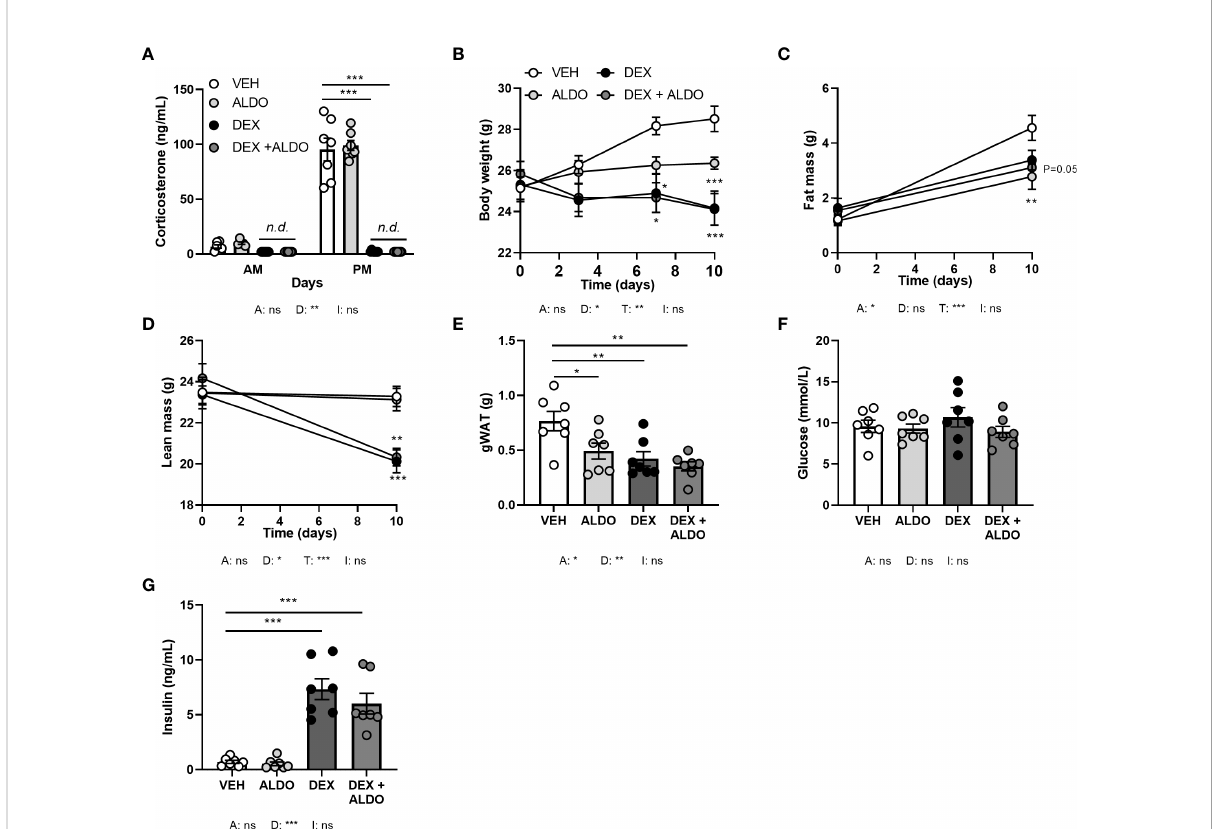
FIGURE 7 Aldosterone add-on treatment did not in fl uence the metabolic effects of dexamethasone. Mice received a high-fat diet mixed with dexamethasone (DEX) or vehicle (VEH) and were subcutaneously implanted with aldosterone (ALDO) or vehicle pellets for 10 days. (A) ALDO did not affect corticosterone levels at AM (ZT1) and PM (ZT11) of the light phase, while CORT levels were not detected (n.d.) after DEX and DEX + ALDO treatment. (B – D) DEX + ALDO did not in fl uence the DEX-induced reduction of body weight, fat mass and lean mass. (E, F) 6 h-fasted plasma glucose or insulin levels were unaffected by ALDO and DEX + ALDO. (G) ALDO, DEX and DEX + ALDO reduced gonadal white adipose tissue (gWAT) weight Statistical signi fi cance was calculated using 3-way ANOVA in (A-D) and 2-way ANOVA analysis in (E – G) . Depicted below the graphs are the P-values of the ANOVA tests for either ALDO (A), DEX (D), or the interaction between ALDO and DEX (I). *P < 0.05, ** P < 0.01, ***P < 0.001. 'ns' means 'not signi fi